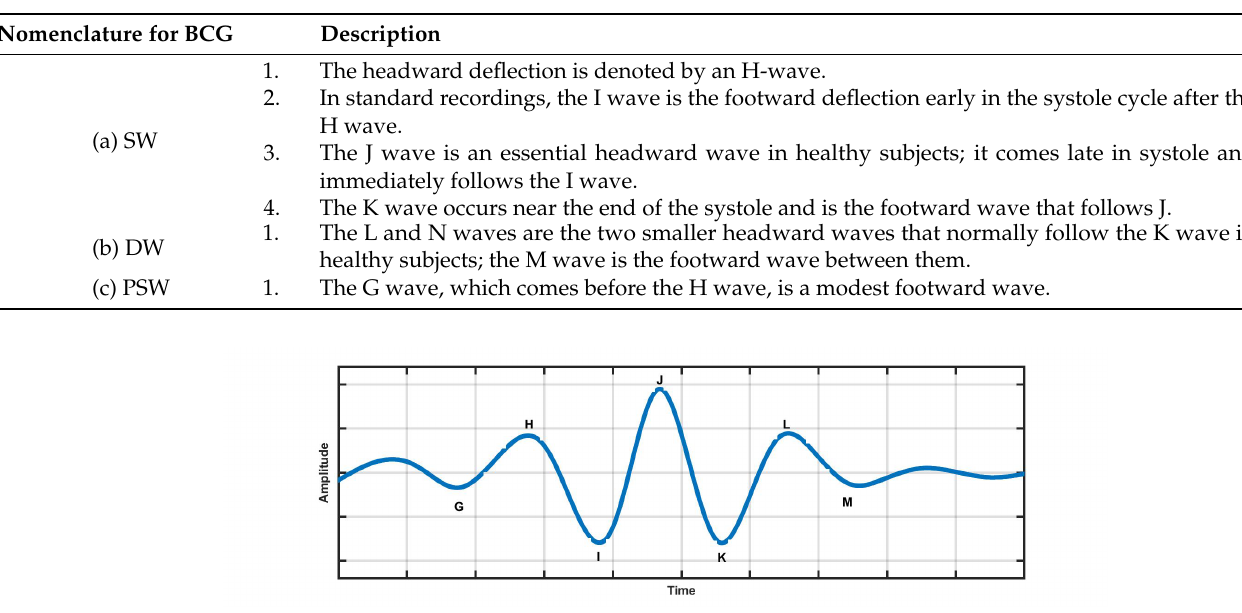
Figure 1. Normal BCG